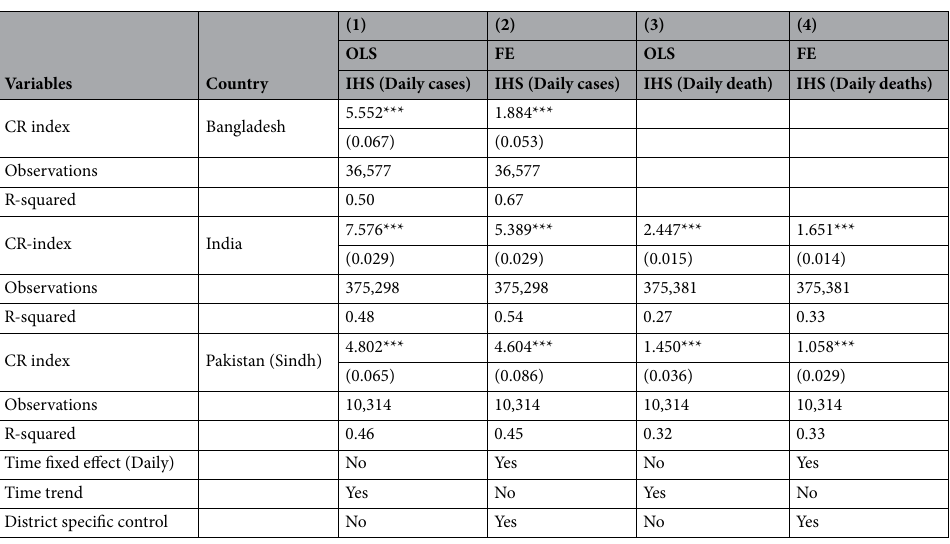
Table 2. OLS and FE regression models. Robust standard errors in parentheses. *** p < 0.01, ** p < 0.05, * p <